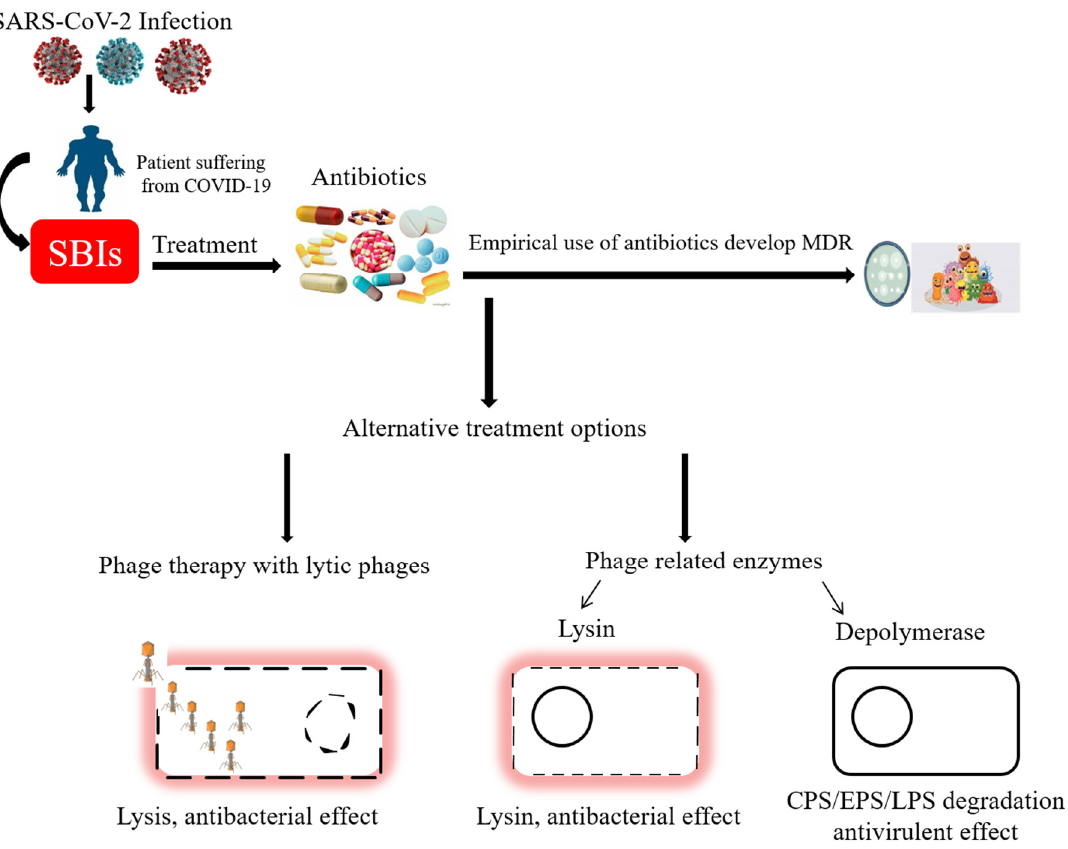
Figure 1. Schematic representation of drug-resistant secondary infections in SARS-CoV-2-infected patients and possible alternative treatments [50,51].